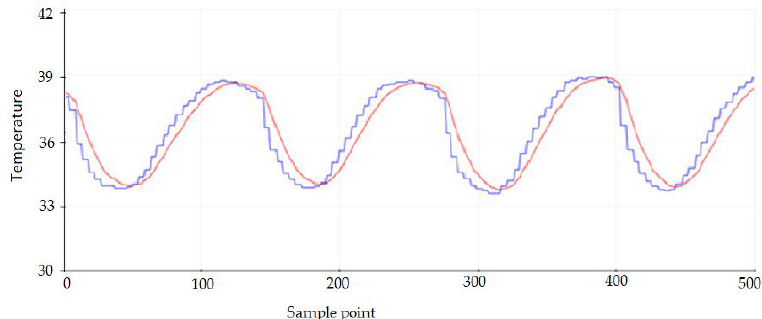
Figure 16 . High-frequency ripple and filtered signal. Figure 16. High-frequency ripple and filtered signal.